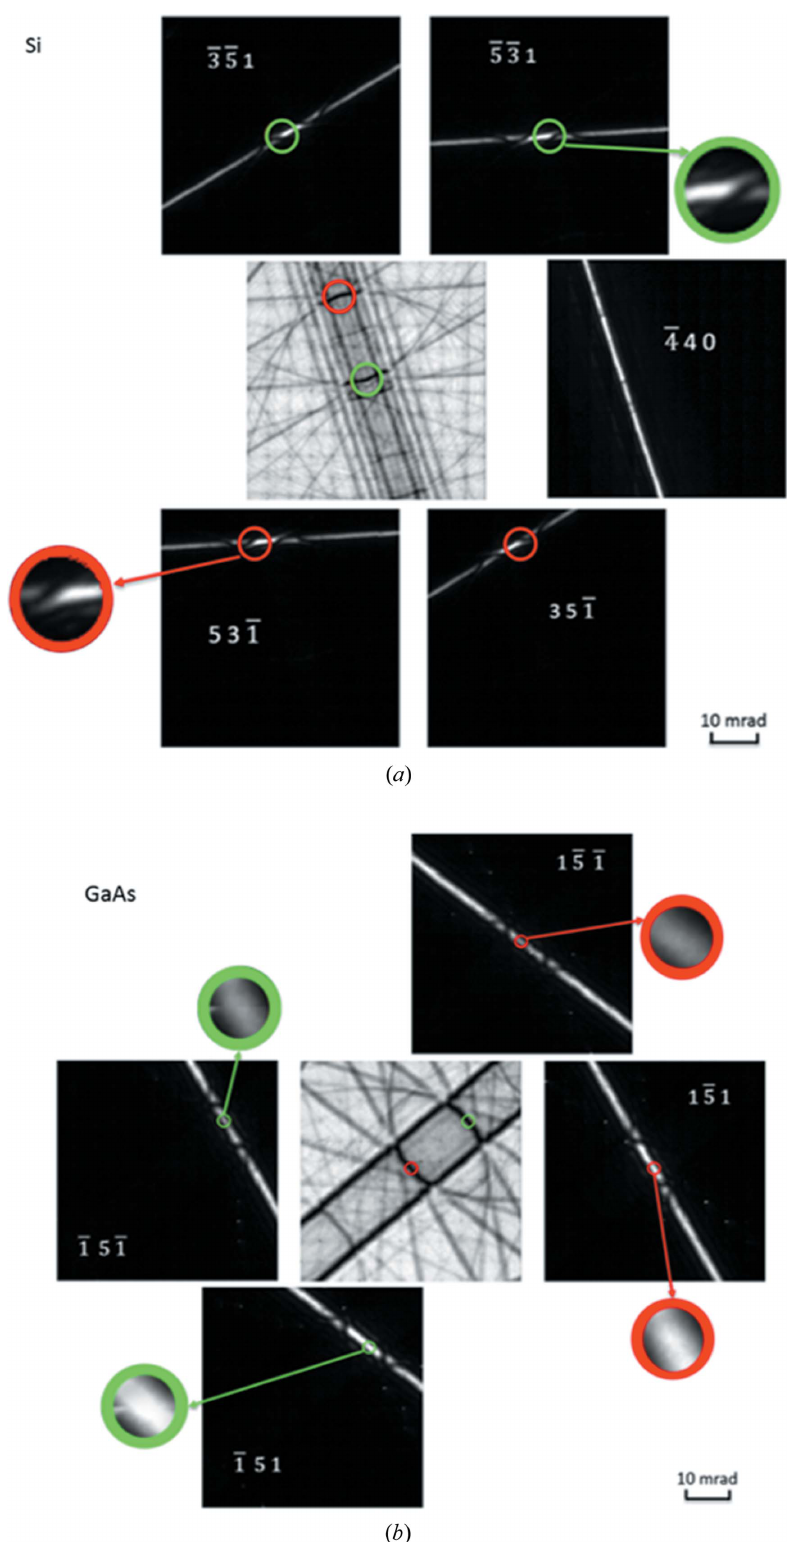
Figure 8 Reconstructed LARCBED patterns of a few selected reflections for ( a ) Si [118] and ( b ) GaAs [510] at 200 kV. In each figure, a pair of three-beam conditions that involve two Friedel-pair reflections are labelled with circles in red (dark in greyscale) and green (light in greyscale). The sizes of the circles are chosen such that the three-beam conditions and their closest neighbourhoods are included while the neighbouring Bragg conditions are